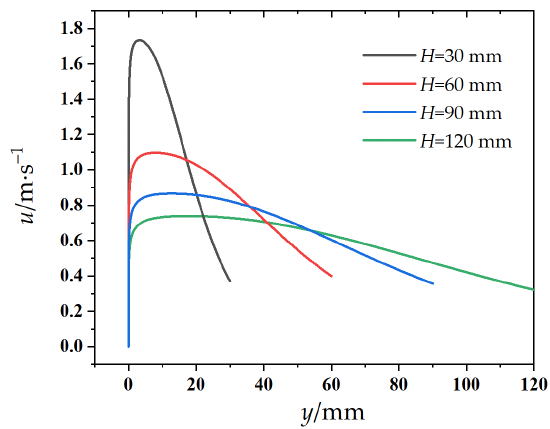
Figure 13. Relation between lift index and particle diameter under four different h / R .